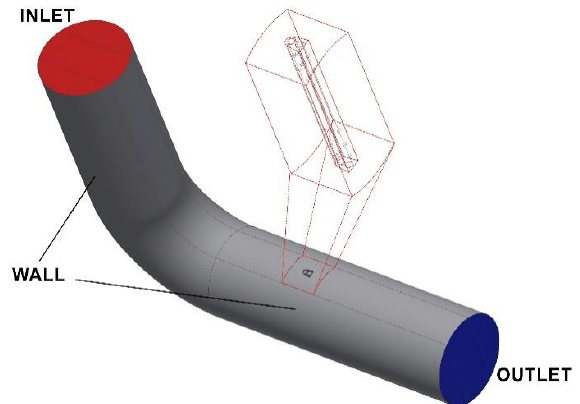
Figure 5. Boundary conditions for the analyzed flow system, with inlet and outlet sections and the enlarged part of the analyzed probe shortened (for better visualization).